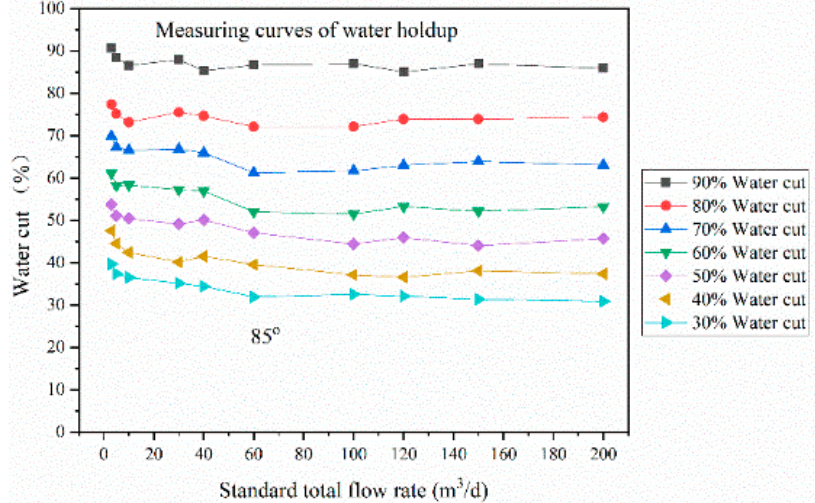
Figure 7. Water holdup measurement chart (inclination angle 85°).